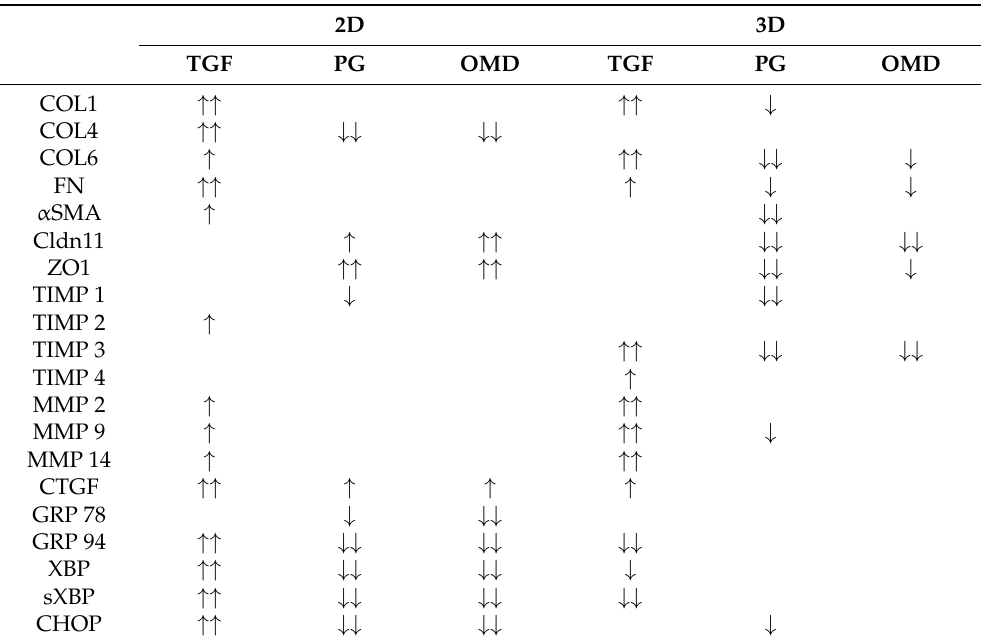
CHOP ↑↑ ↓↓ ↓↓ ↓ Statistically significant differences between TGF untreated control and TGF, or TGF and PG or OMD are designated as follows; ↑ : significant increase ( p < 0.05), ↑↑ : significant increase ( p < 0.01), ↓ : significant decrease ( p < 0.05), ↓↓ : significant decrease ( p <